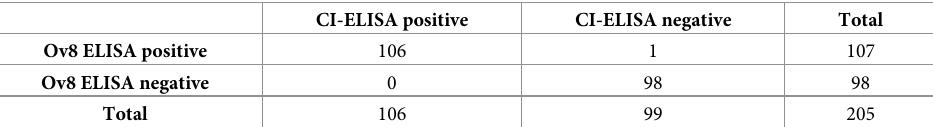
Sheep 10/10 (OvHV-2) 10/10 a Animal species the serum samples were taken from. b Number of serum samples that were positive in Ov8 ELISA from a total of CI-ELISA positive samples tested. The MCFV detected in the infected animal species tested is indicated in parenthesis. c No CI-ELISA negative samples available.